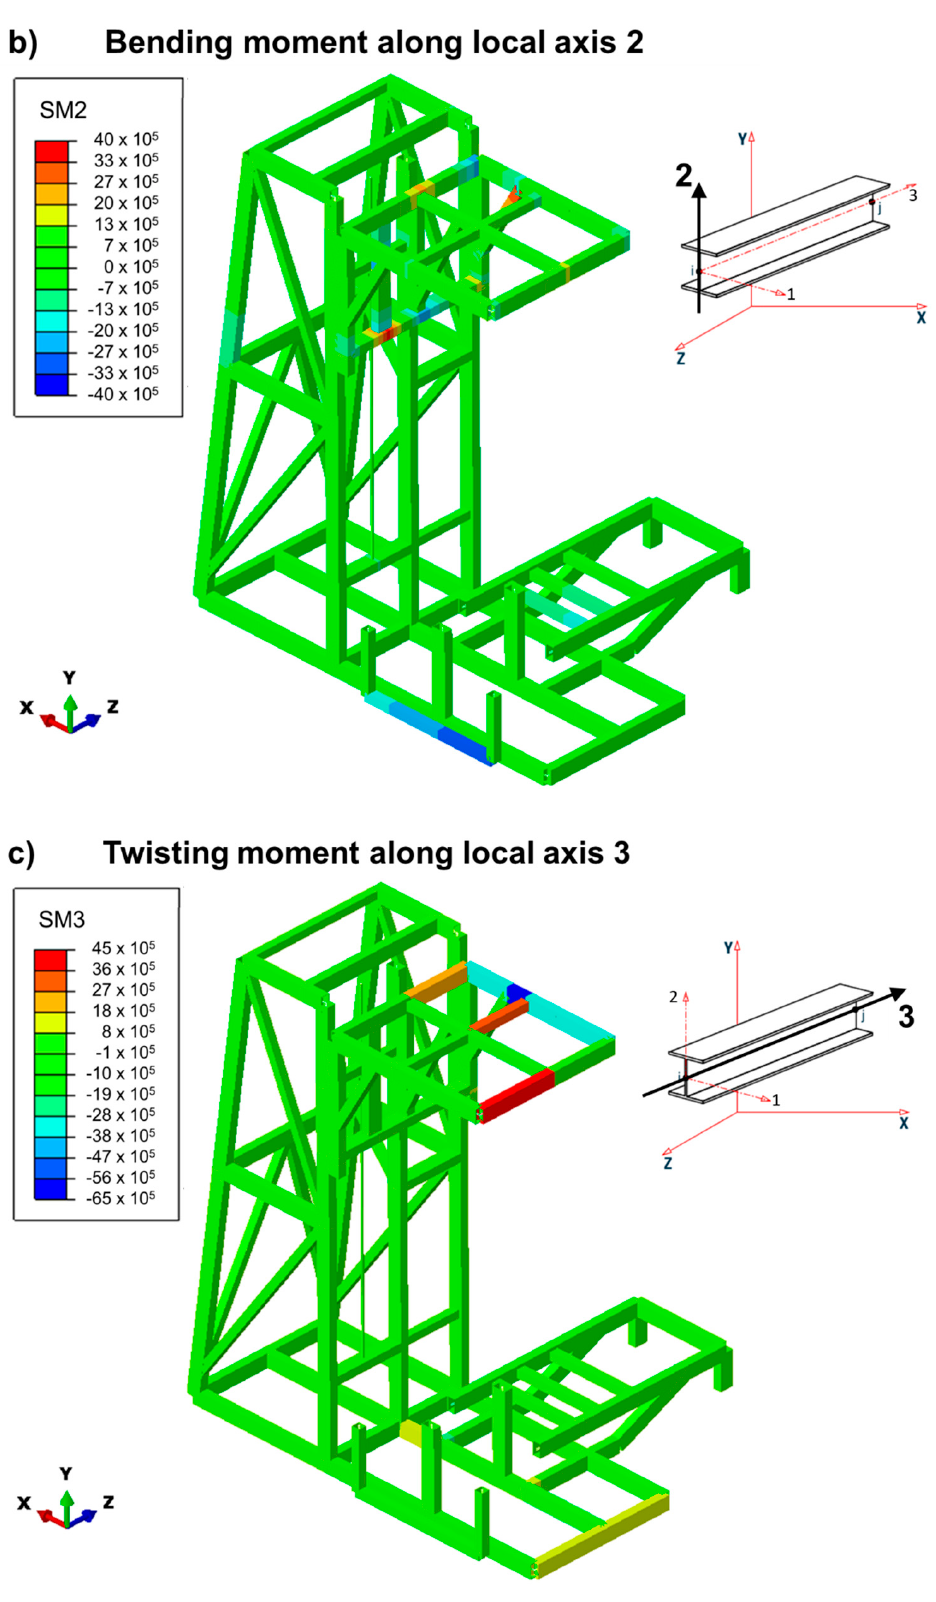
Figure 4. Contour plots of ( a , b ) bending and ( c ) twisting moments of the machine undergoing the static and service loads; 1D elements shown through a 3D rendering with a scale factor equal to 0.5 to improve visibility; units in Nm.